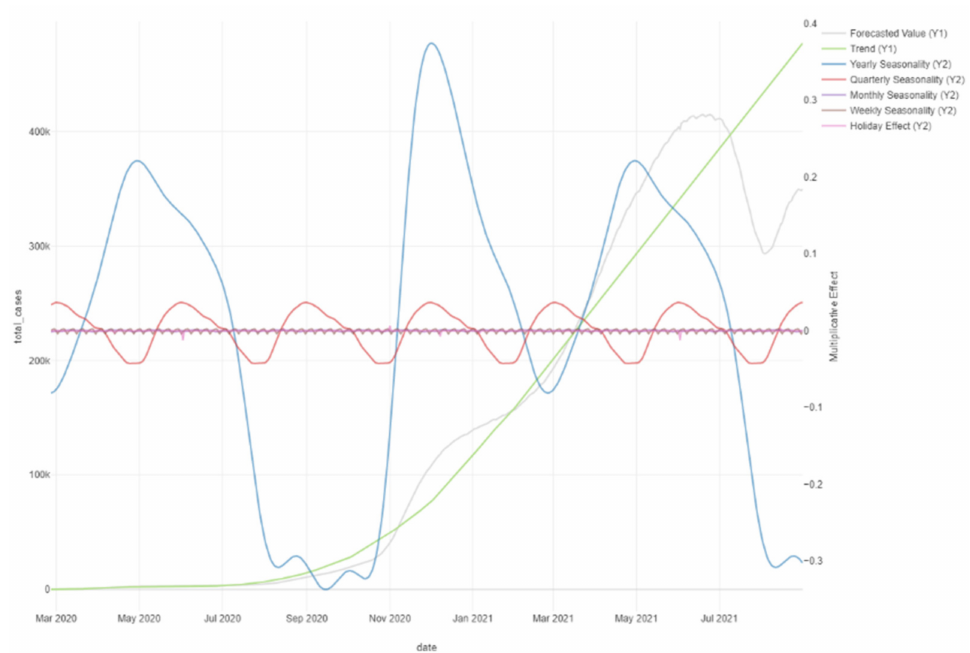
Figure 31. Prophet forecast